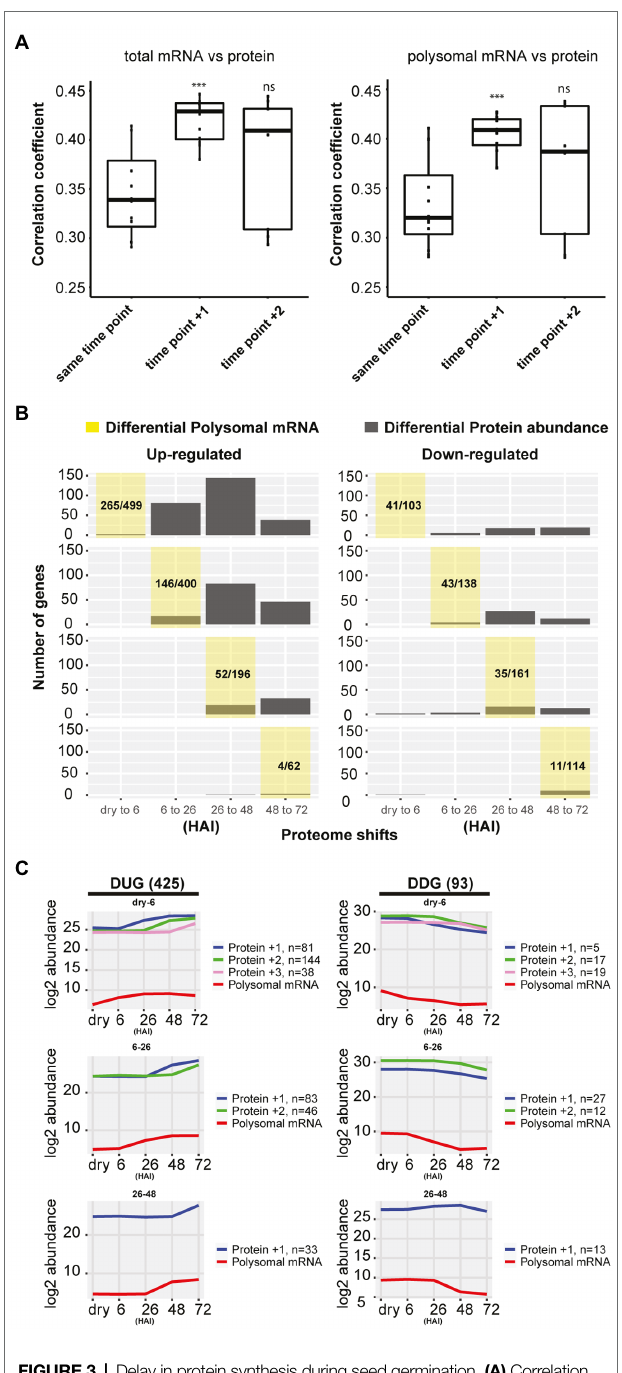
FIGURE 3 | Delay in protein synthesis during seed germination. (A) Correlation analysis between the total mRNA, polysomal mRNA level, and the protein abundance of the next time-points. Time-points +1 and +2 for the polysomal mRNA are used for the correlation with the protein abundance ( *** p < 0.001; Wilcoxon rank-sum test). (B) Delay in protein abundance changes compared to changes in polysome-associated mRNAs comparing two consecutive hours after imbibition (HAI) time-points. The yellow shaded area represents the germination time-point under investigation and indicates when the polysomal mRNAs are for the first time up-/downregulated. The corresponding distribution of protein changes of these genes changed in polysomal mRNA at the yellow shaded time-point is indicated in grey. The proportions of up- or downregulated